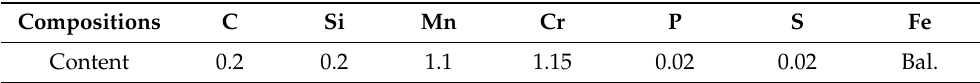
Table 2. Chemical composition of 20MnCr5 steel